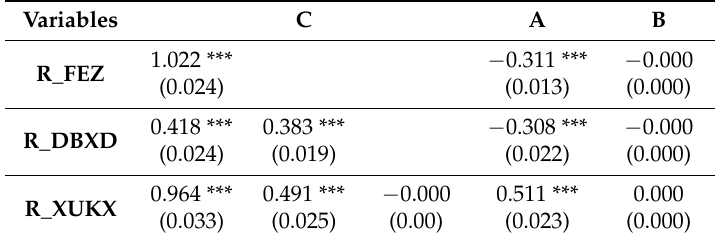
Table 11. Diagonal BEKK for Europe Market ETF returns (Before GFC) (10 September 2007 to 30 October 2007).